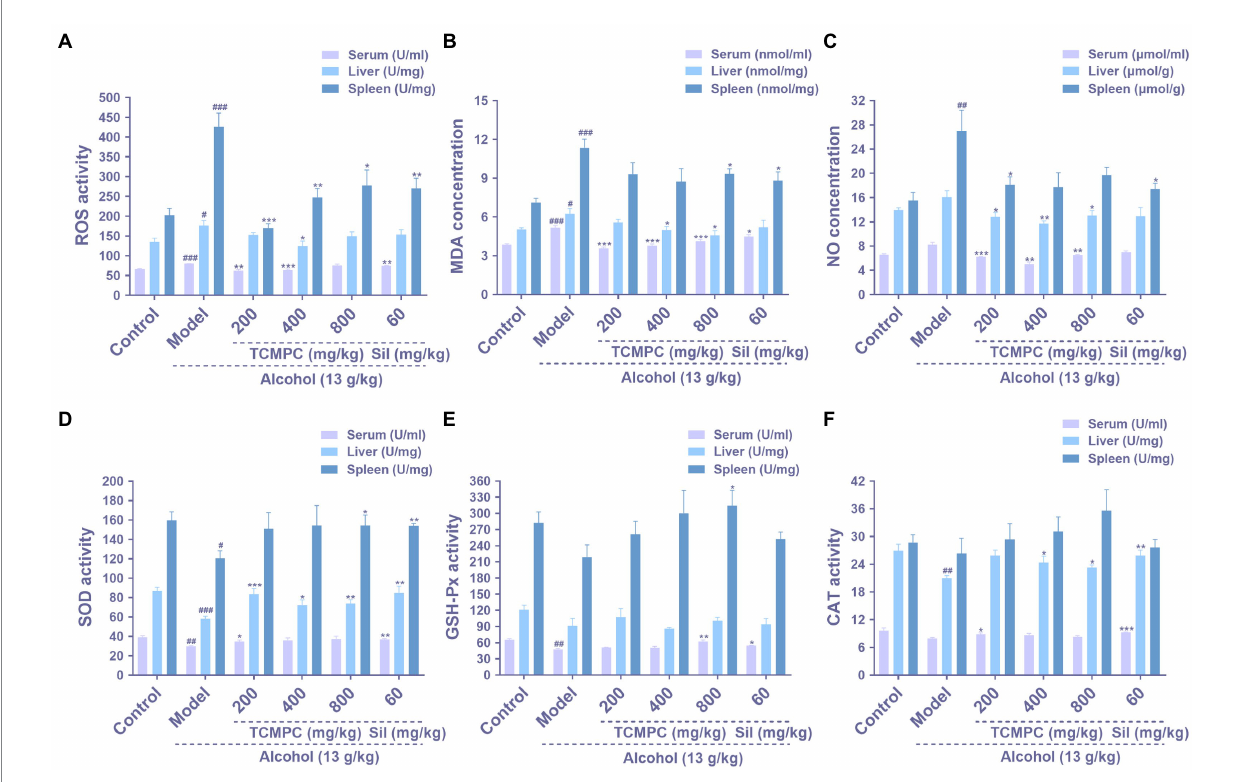
FIGURE 2 Antioxidative effects of TCMPC on alcohol-induced ALI mice. The levels of ROS (A) , MDA (B) , NO (C) , SOD (D) , GSH-Px (E) , and CAT (F) in serum, liver, and spleen were detected by ELISA kit. Data are expressed as mean ± SD, n = 10. # p < 0.05, ## p < 0.01, and ### p < 0.001, versus control group. * p < 0.05, ** p < 0.01, and *** p < 0.001, versus model